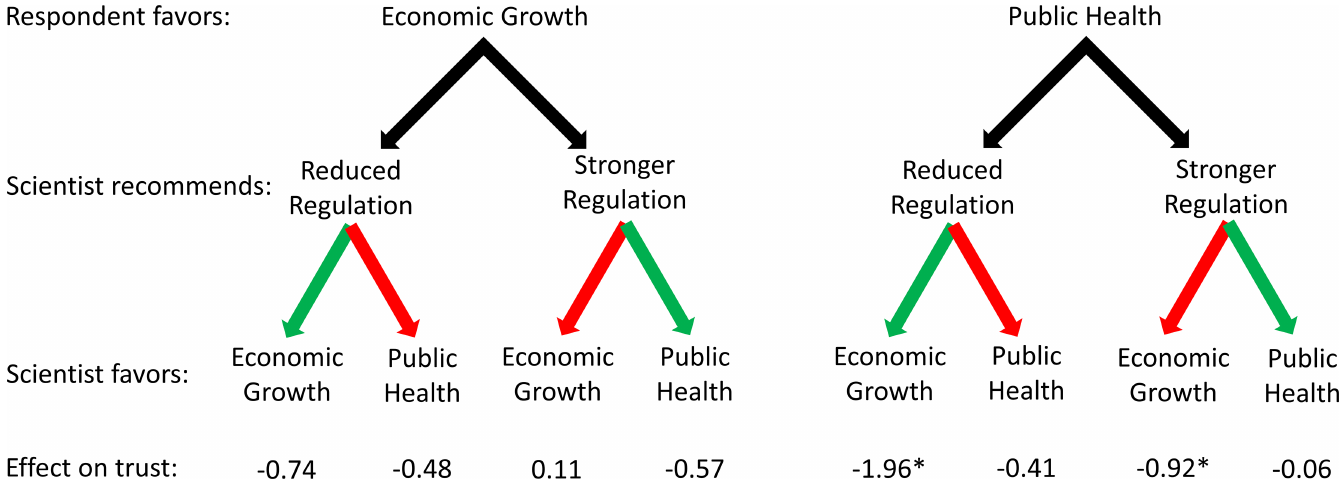
Fig 4. Effects of scientists’ policy recommendations and expressedvalues on respondents’ trust in them. Effects are relative to a scientist not expressinga preferencefor particular values and are net of control variables; see Table 1. Green arrows are used when the scientist’s recommendation coincideswith the scientist’s values; red arrows are used when the scientist’s recommendation conflicts with the scientist’s values.